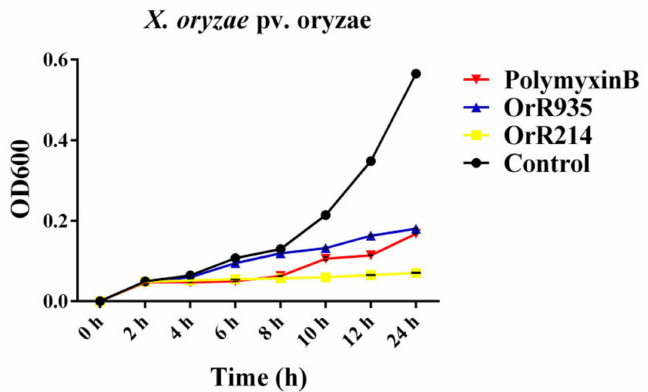
Figure 6. Time-Kill curve. The bacterial growth curve confirmed the inhibitory e ff ects of the antimicrobial peptides OrR214 and OrR935. Time kill kinetics of X. oryzae pv. oryzae by antimicrobial peptides OrR214, OrR935, and Polymyxin B at their MICs. Three individual experimental data points were collected for the mean values.